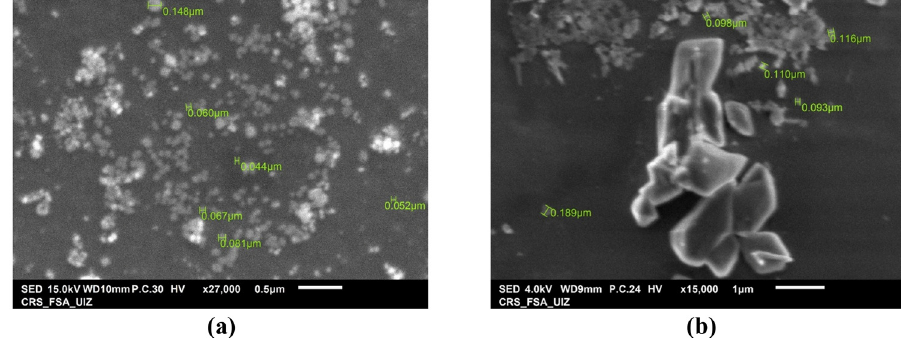
Figure 6: SEM image of AgNPs synthesized by starch ( a ) and dry microalgae biomass ( b )